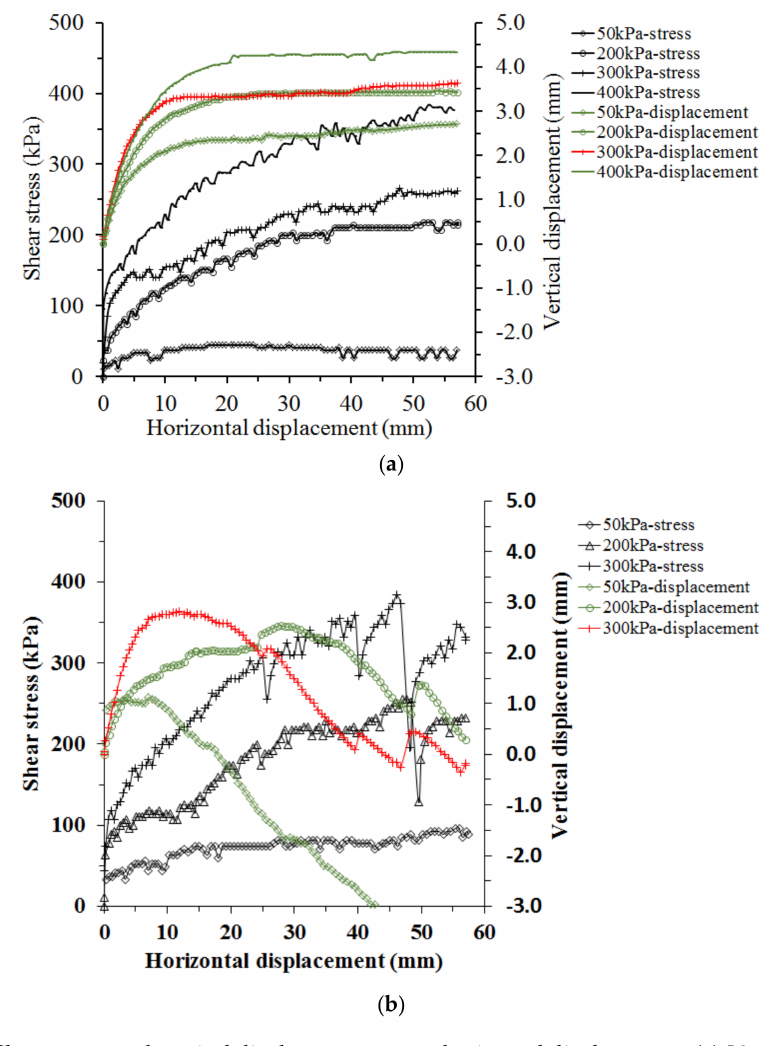
Figure 12. Shear stress and vertical displacement versus horizontal displacement. ( a ) L 3 stone content of 50%; ( b ) L 3 stone content of 70%.